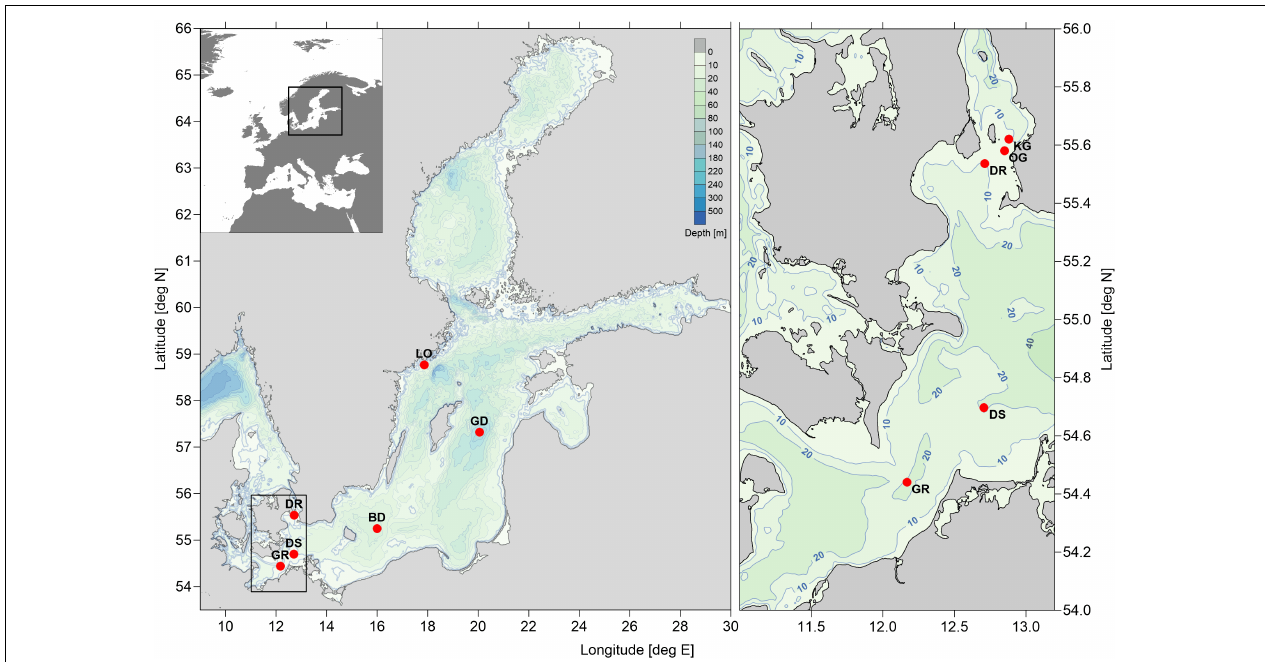
FIGURE 1 | Topography of the Baltic Sea and the location of the time series stations used in this study. Gedser Rev (GR), Darss Sill (DS), Drogden Sill (DR), Oskarsgrundet (OG), Kalksgrundet (KG), Bornholm Deep (BD), Gotland Deep (GD), Landsort